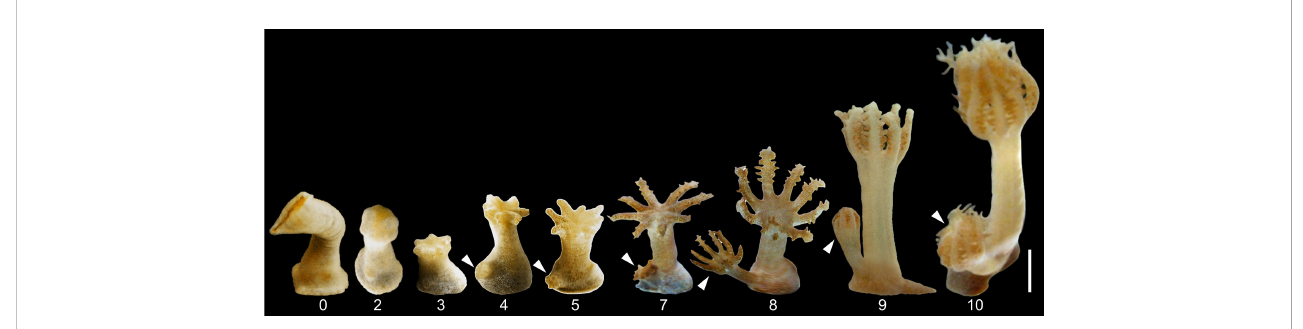
FIGURE 2 Timeline of oral disc regeneration of amputated polyps of Xenia umbellata from day 0 until regeneration into a fully functional polyp on day 10. Arrowheads indicate developing daughter buds showing similar morphogenesis. Scale bar 1 mm applies to all images.